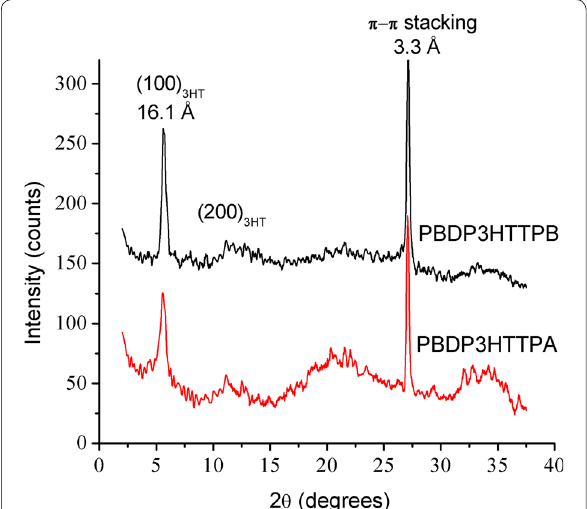
Fig. 6 X‑ray diffraction (XRD) patterns of PBDP3HTTPA and PBDP3H‑ TTPB